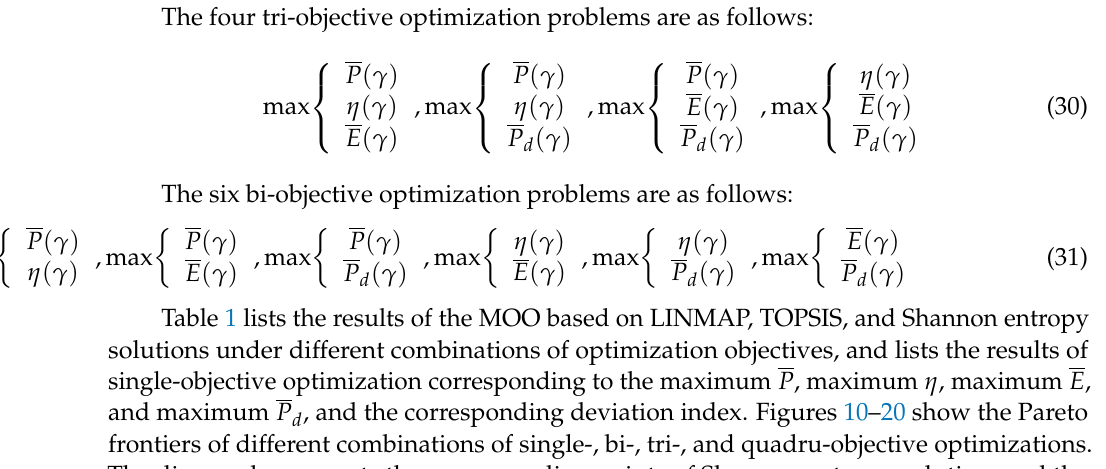
/ v v versus τ . 4 1